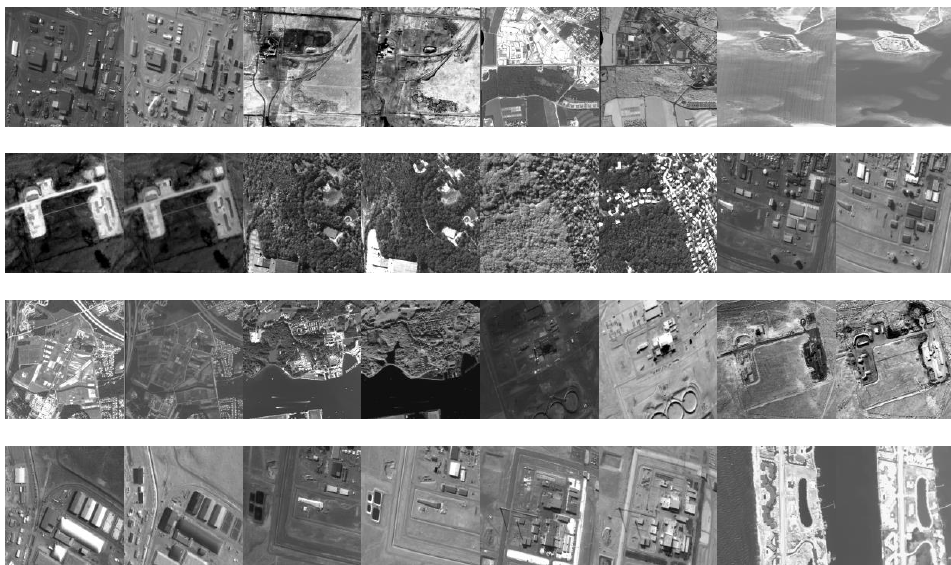
Figure 3. Multisource remote sensing image data sets.